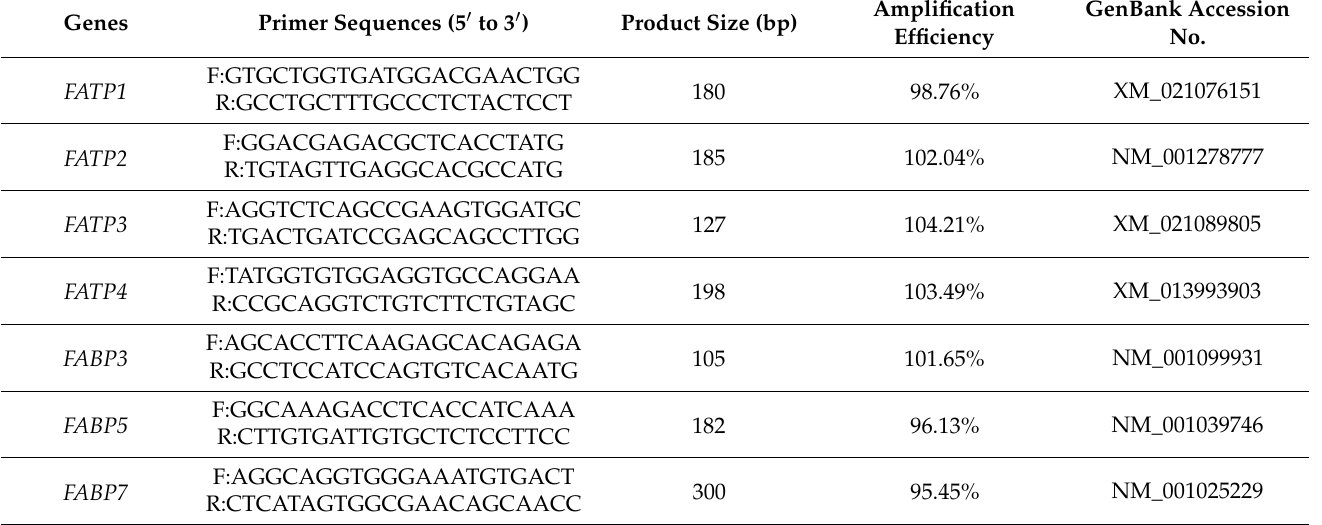
Table 1. Primers used for